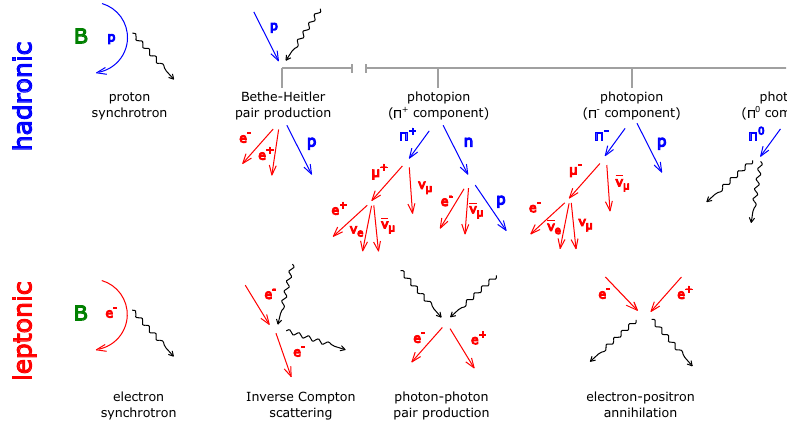
Figure 1. Schematic illustration of the main hadronic and leptonic processes that are included in our numerical